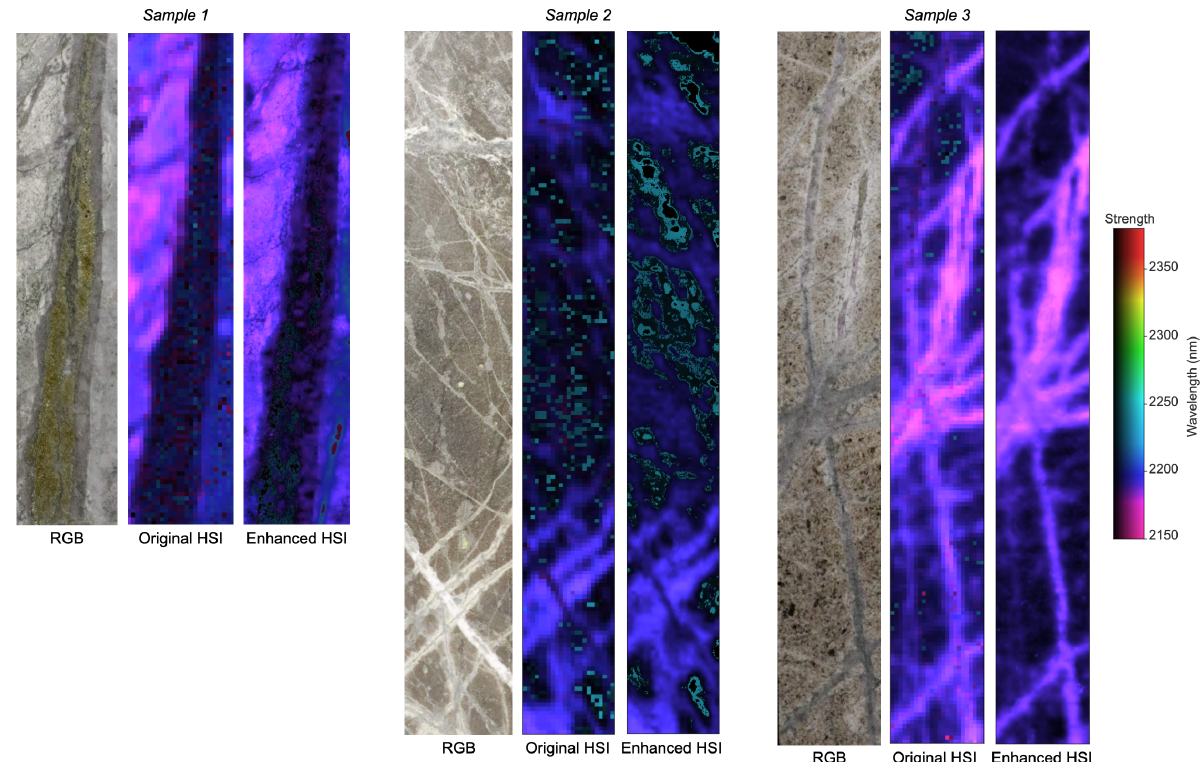
Figure 6. Minimum wavelength maps performed over the range between 2130 and 2370 nm for both the original and enhanced hyperspectral images (HSI). A stretch for visualization was performed between 2150 and 2370